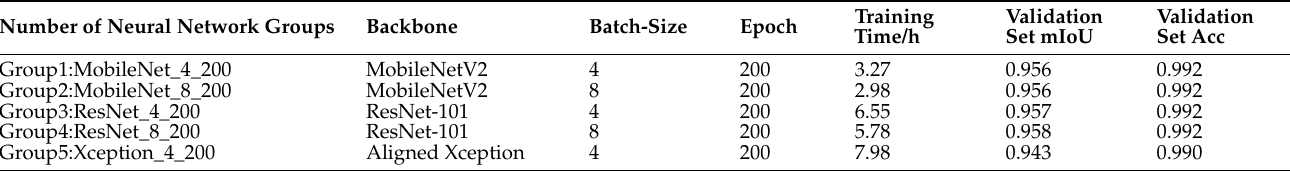
Table 3. Comparative testing of DeeplabV3+ models of five groups of backbone neural networks.